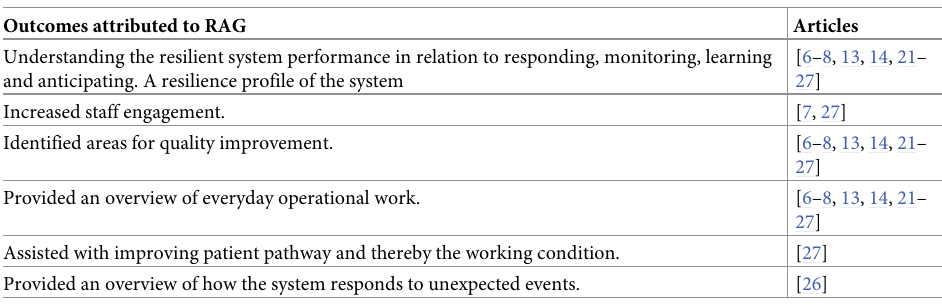
Table 3. Outcomes of resilience assessment grid use in healthcare. Outcomes attributed to